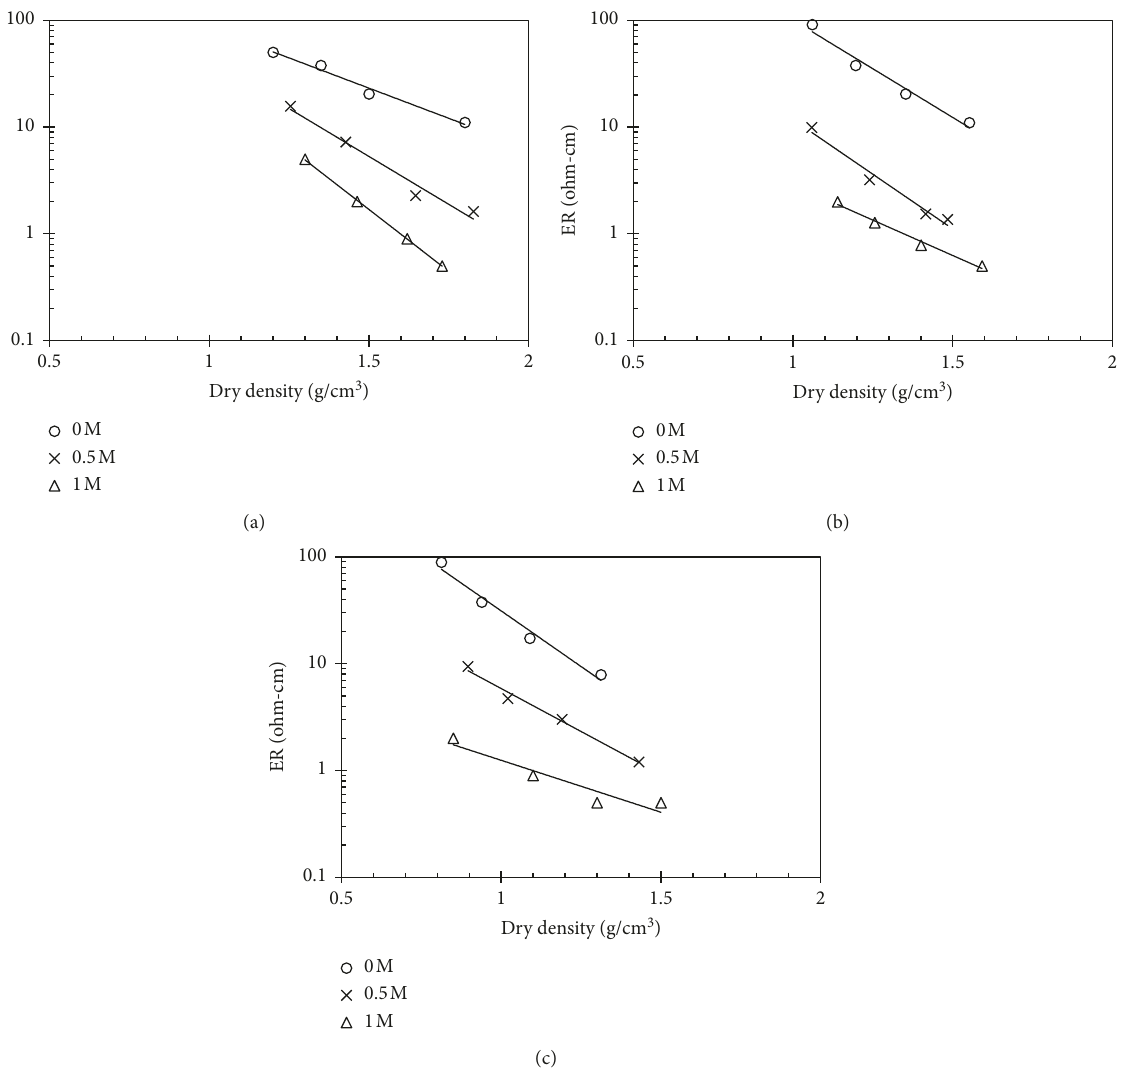
Figure 8: ER for k10 at (a) W c (cid:31) 15%, (b) W c (cid:31) 20%, and (c) W c (cid:31) 25% water content in 0 M, 0.5 M, and 1M NaCl